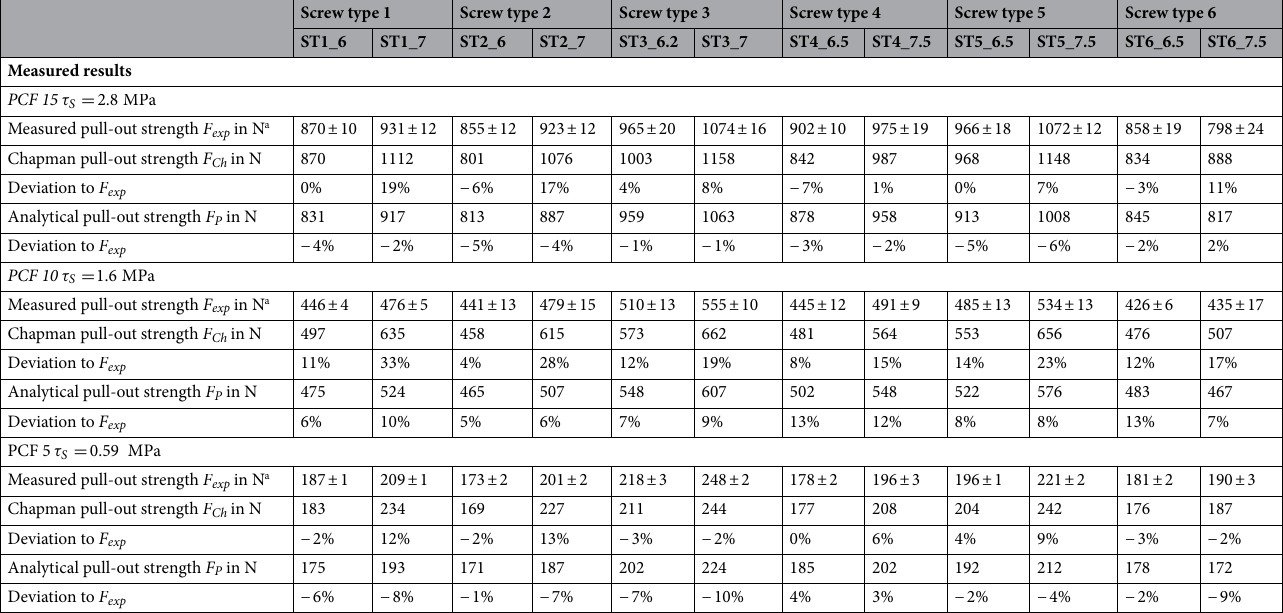
Table 5. Comparison of the analytical calculations with the measurement results. a Given as mean value ± one standard